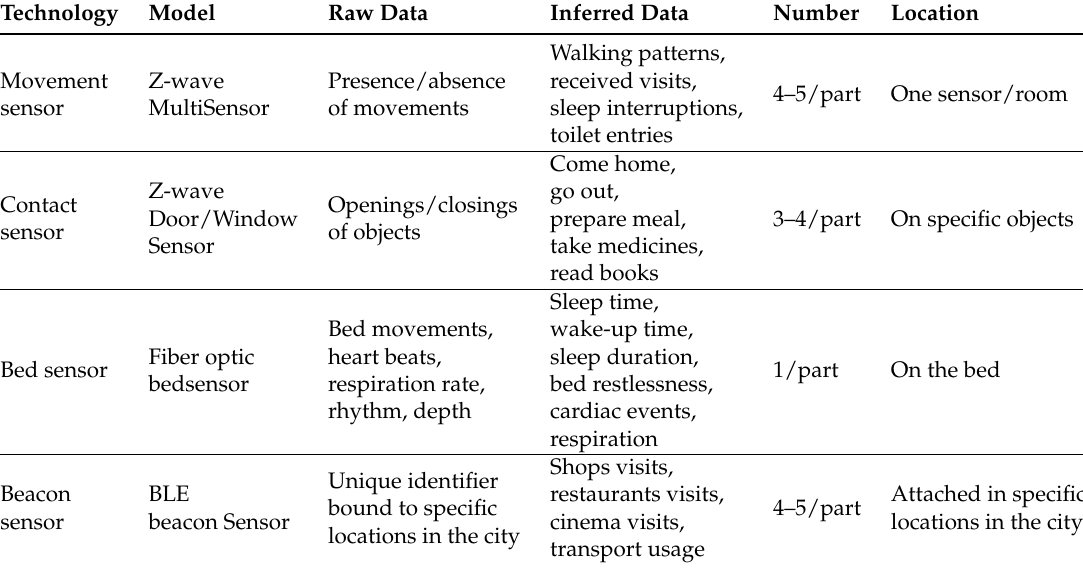
Table 3. Deployed sensors’ characteristics and